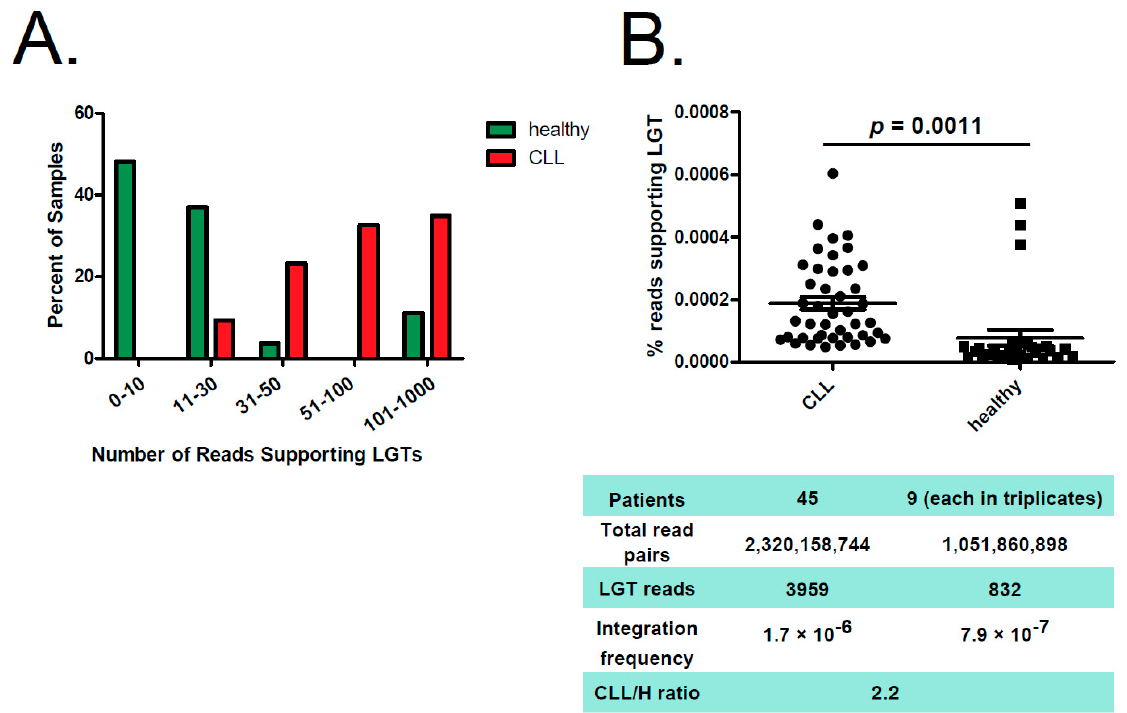
Figure 2. Reads supporting bacterial–human LGT were enriched in CLL versus non-leukemic B cells. ( A ) Distribution of reads supporting LGT in CLL samples (red) and in healthy B cells (green). The graph shows the percentage of samples featuring indicated number of reads supporting LGT. ( B ) The figure displays a comparison between CLL samples from CLL patients and B-cell samples from healthy (H) donors, whereas percentage of reads supporting bacterial–human lateral gene transfer is shown. Median is indicated. Significance was calculated using unpaired two-tailed t -test. Below, key information is summarized for both